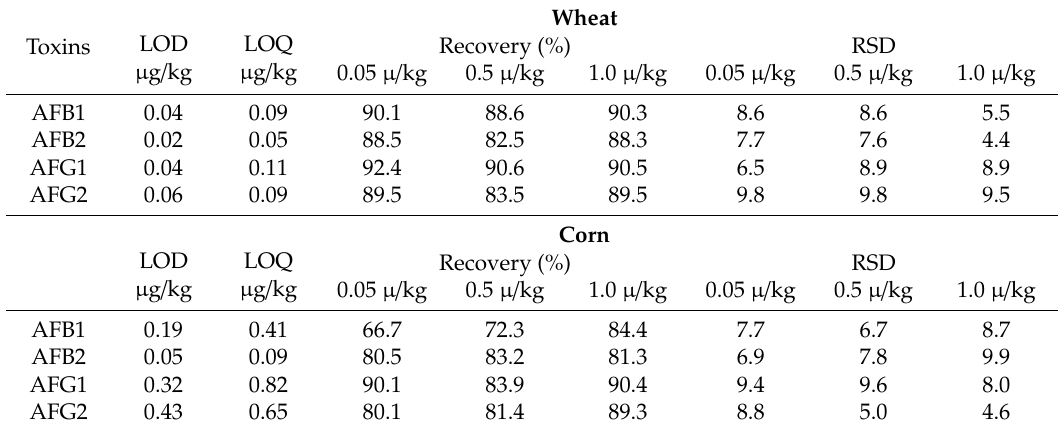
Table 4. Statistical parameters for the determination of AFB1, AFB2, AFG1, and AFG2 in di ff erent food samples by using HPLC